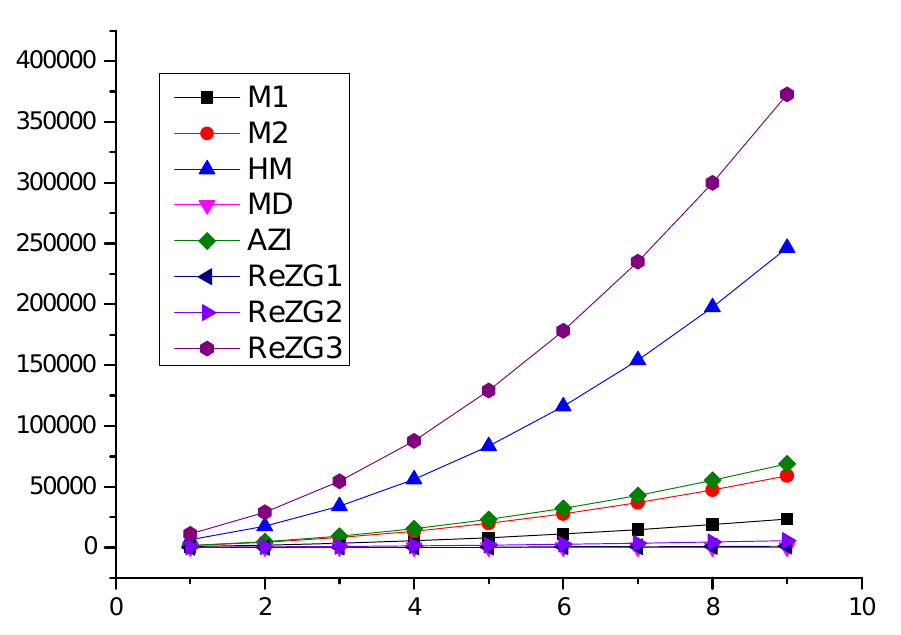
Figure 3. Graphical comparisons of Zagreb indices for p < q and p are